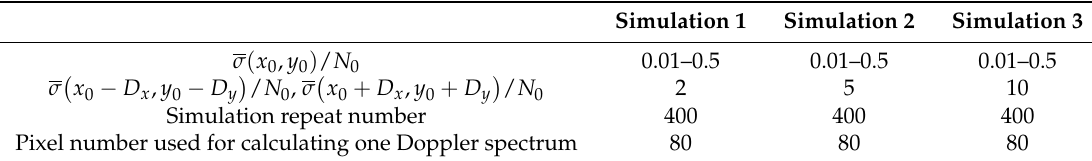
Table 2. Simulation